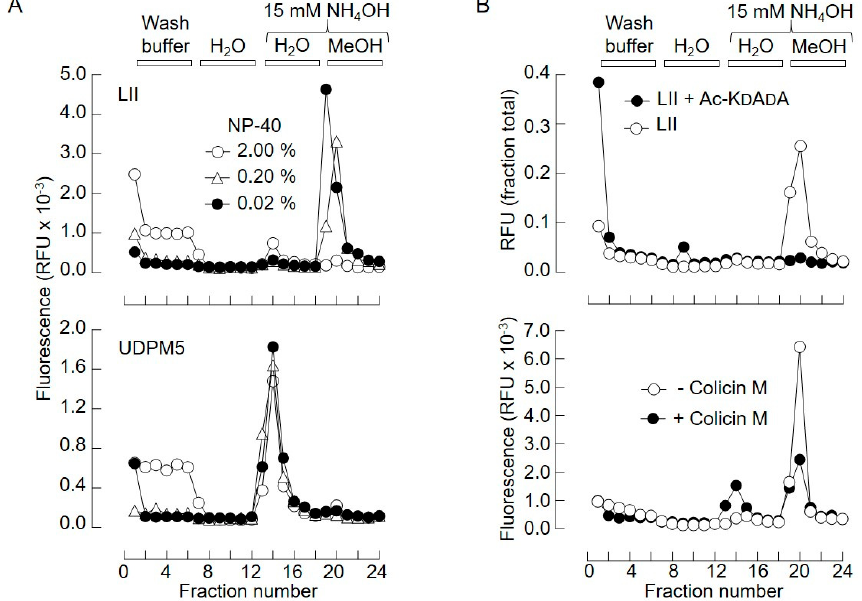
Figure 3. ( A ) Solid-phase extraction of lipid II and uridinyl diphospho (UDP)-MurNAc pentapeptide (UDPM5) from detergent-containing mixtures. ( B ) 500 pmol LII(Lys)55 (upper panel) or UDPM5 (lower panel) was incubated with Vm-beads in Vm wash buffer containing the indicated amounts of nonyl phenoxypolyethoxylethanol (NP-40). The beads were then washed with the indicated solutions and fractions were collected into 96-well plates and monitored for fluorescence. (B, upper panel) 500 pmol LII(Lys)55 was incubated with Vm-beads in the presence of 1.5 µmol (3000-fold excess over lipid II and ~50-fold excess over vancomycin attached to beads) acetyl-Lys-D-Ala-D-Ala (Ac-KDADA). (B, lower panel) 500 pmol LII(Lys)55 was incubated in either the absence or presence of colicin M as described in Section 4. The reaction mixtures were subjected to solid-phase extraction as described above.